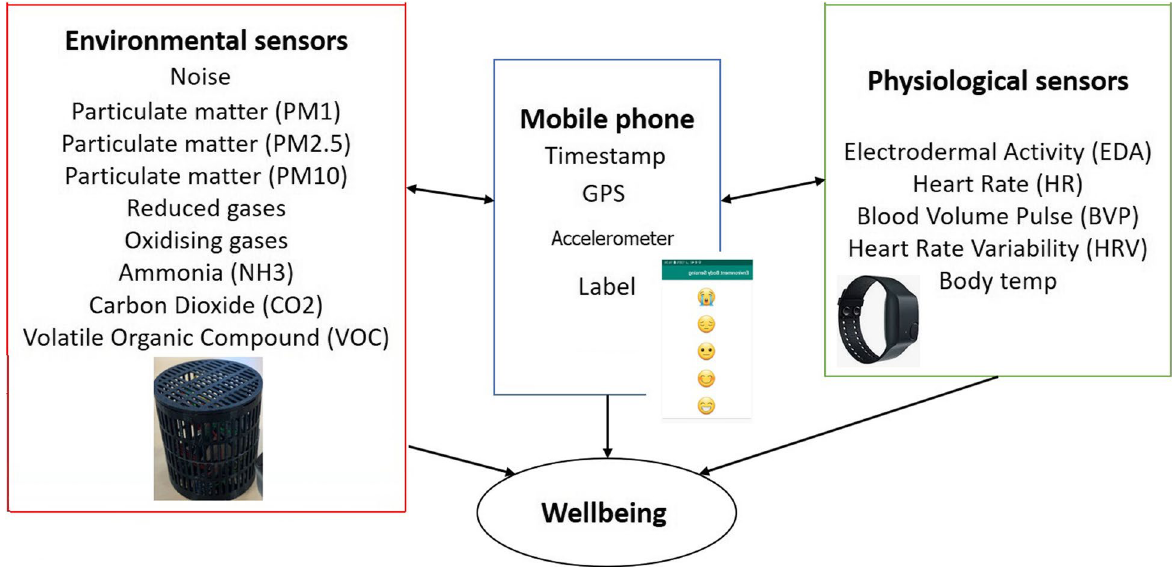
Fig. 4 List of the fused variables collected by each